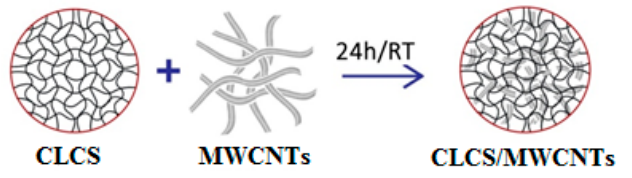
Figure 2. Schematic representation of CLCS/MWCNTs preparation.